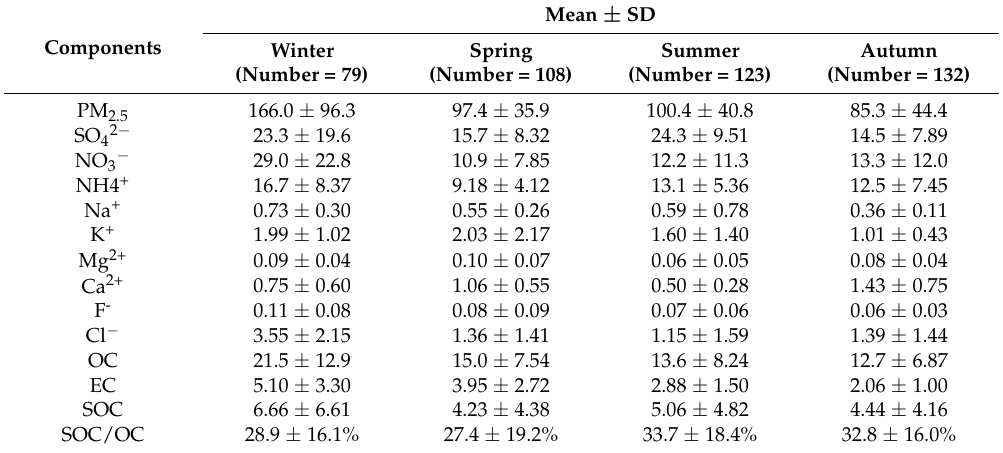
Table 1. Seasonal differences of mass concentrations of PM 2.5 and its main chemical components ( µ g/m 3